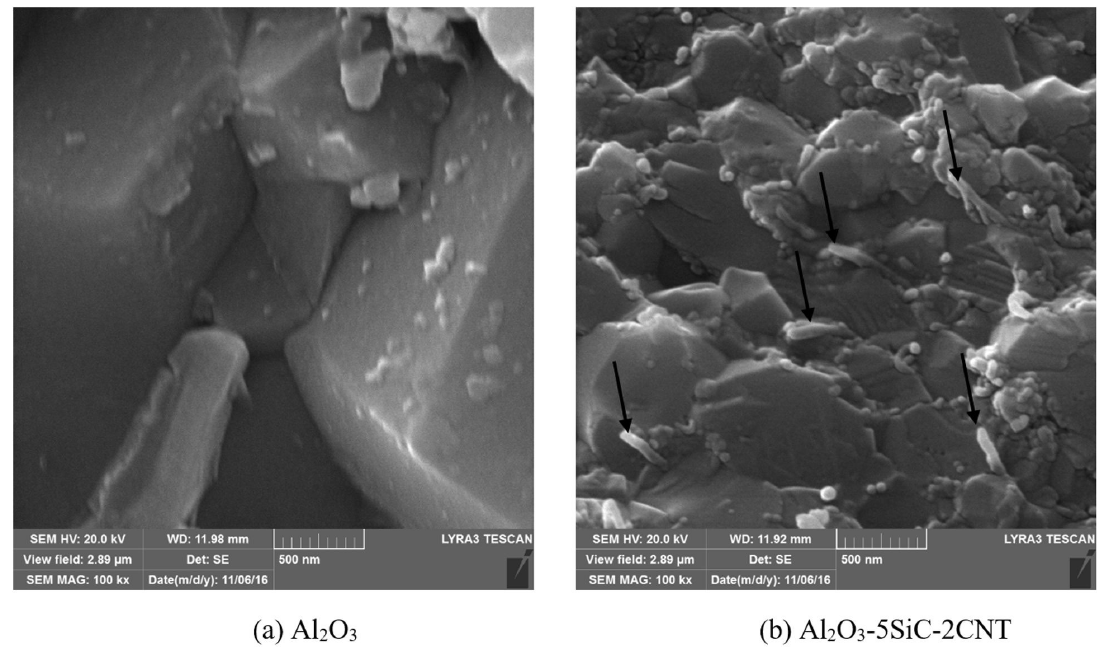
Figure 1: FE-SEM images of surfaces of Al